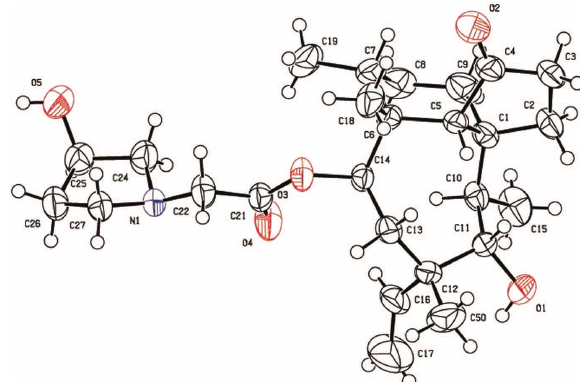
Table 1: Data collection and handling.